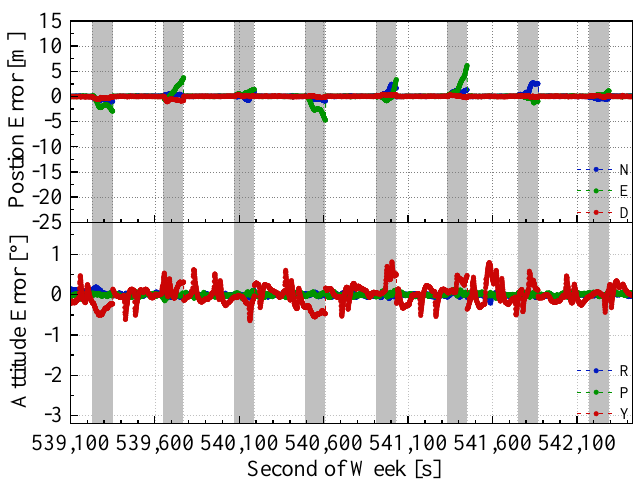
Figure 9. GNSS/IMU/LiDAR-SLAM navigation errors in the test #2 (with 2 min GNSS outages)